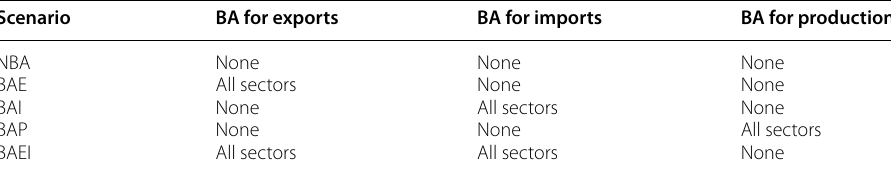
Table 2 Border adjustment scenarios Scenario BA for